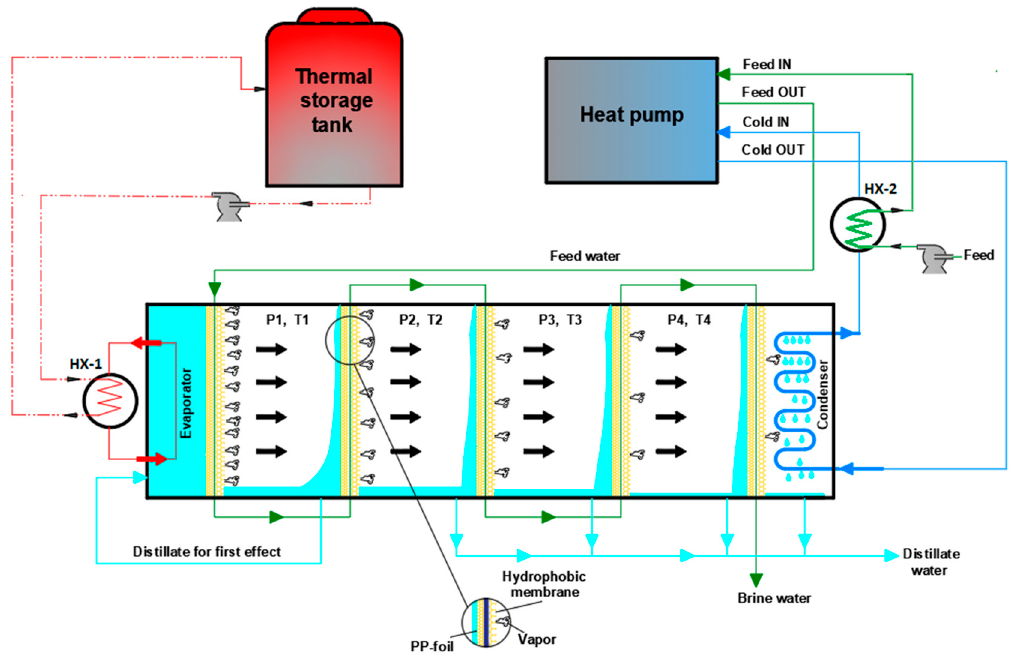
Figure 2. Schematic diagram showing the principle of V-MEMD unit.